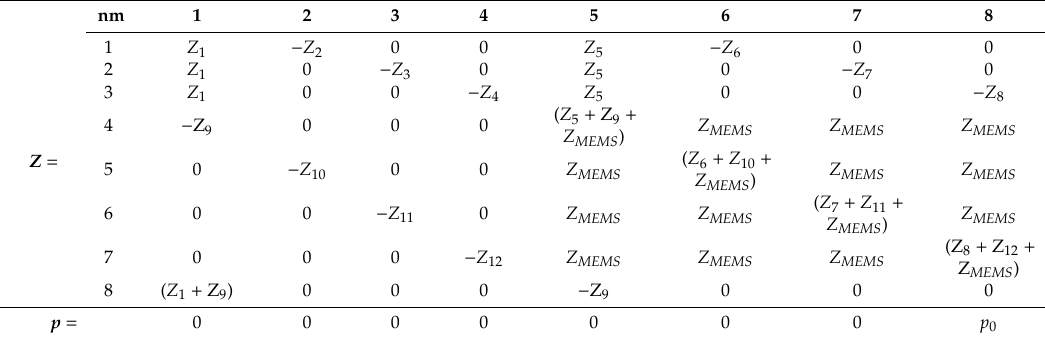
Table A2. Definition of matrix Z and vector p representing a system of linear equations, which describes the lumped element model (LEM) of the microphone sealed with four protective diaphragms.